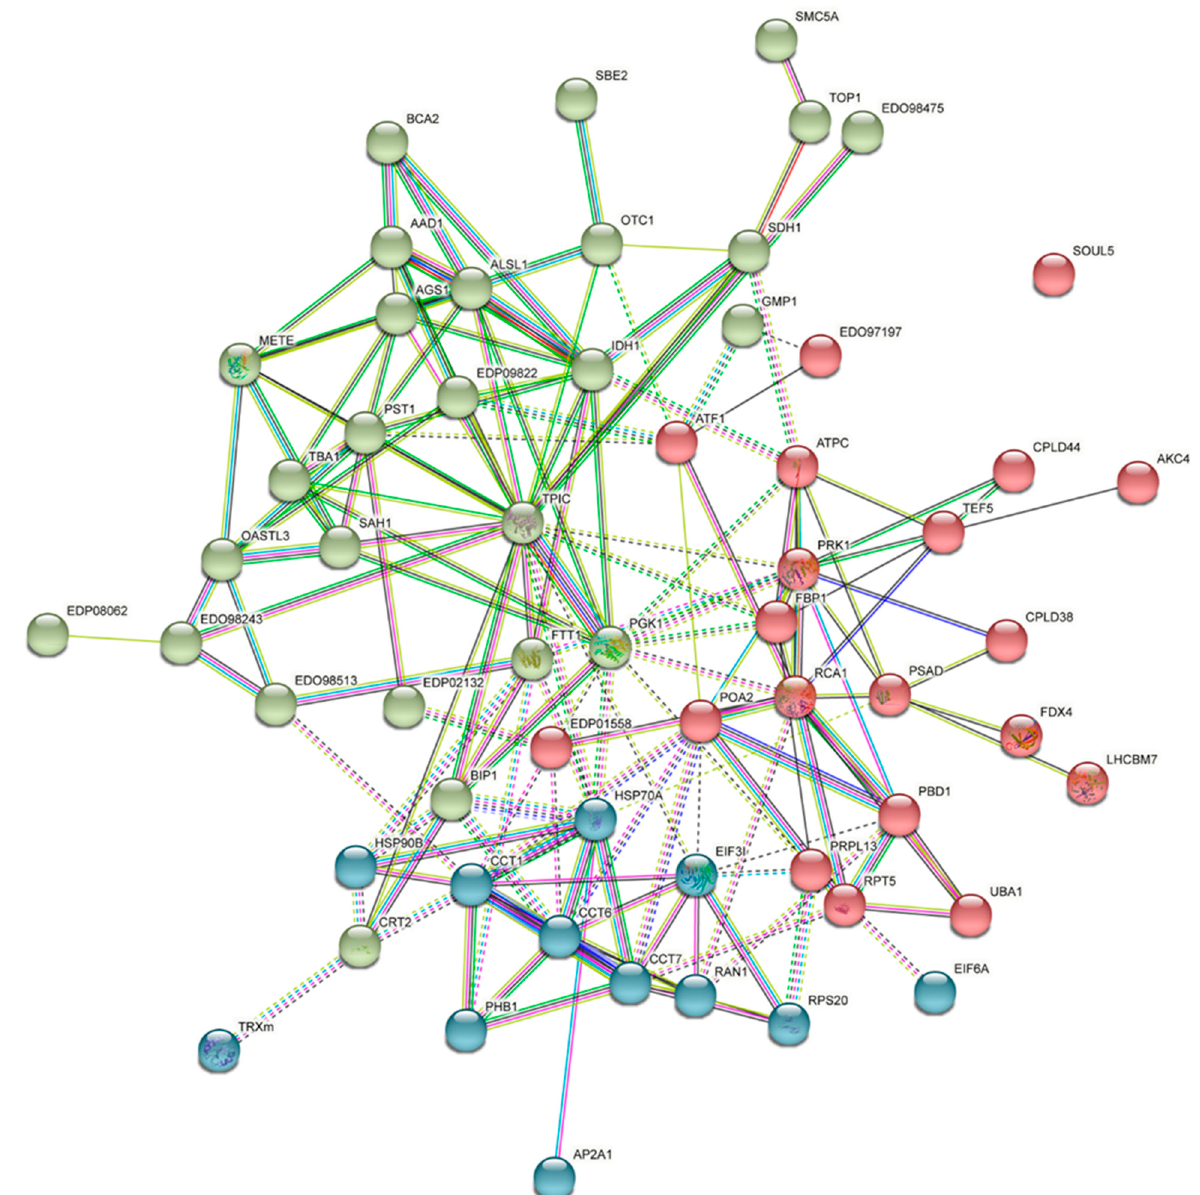
Figure 5. Protein interaction network analyzed in STRING with medium confidence (0.400) and k-means clustering filtered by Chlamydomonas reinhardtii (https://www.string-db.org, accessed on 15 June 2022) (see Table S2 for details).